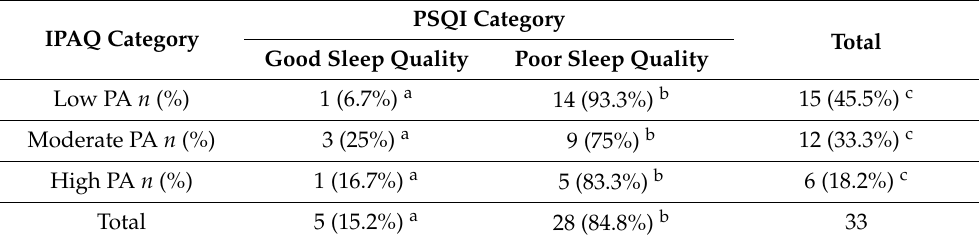
Table 5. Frequency distribution between IPAQ and PSQI.